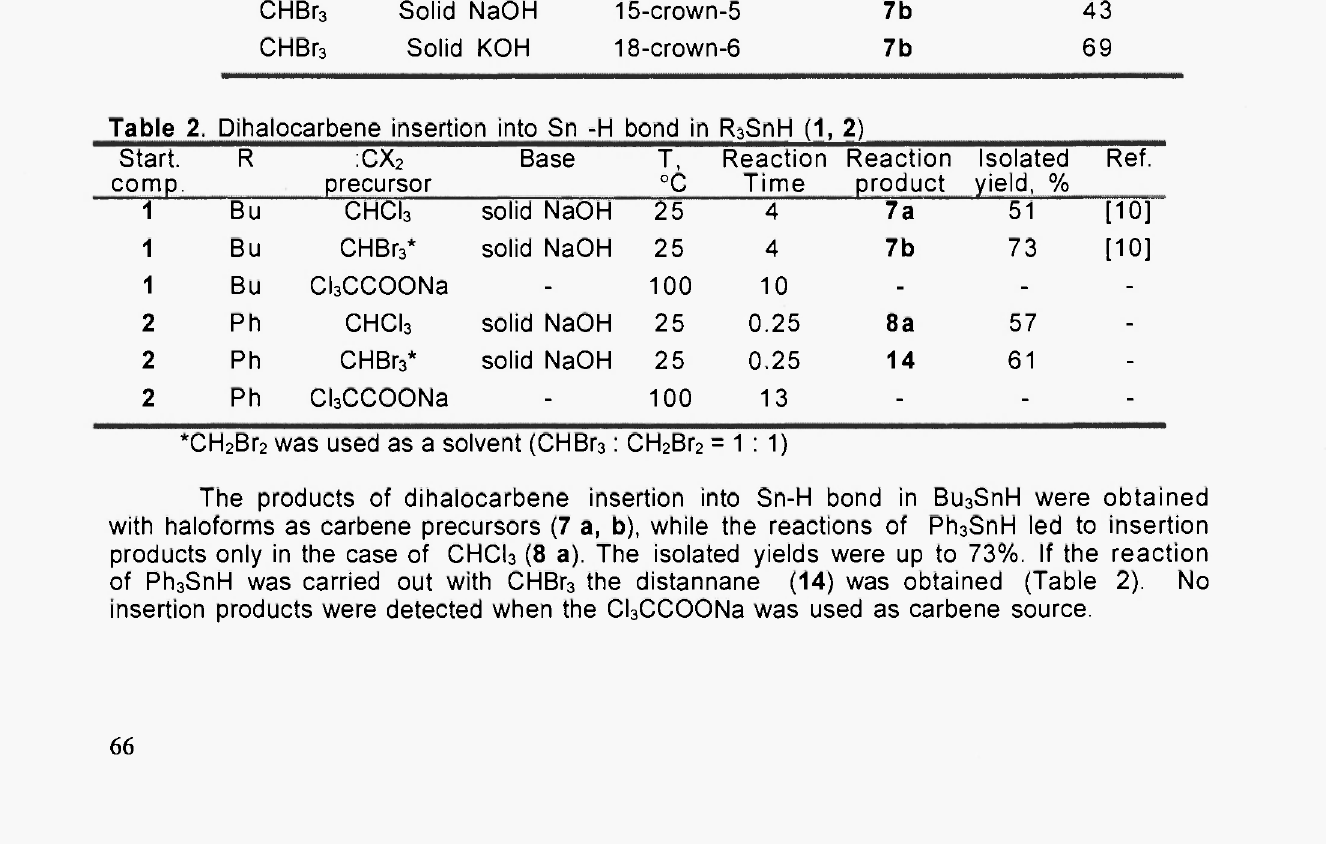
Table 1. Dihalocarbene insertion into the S n -H